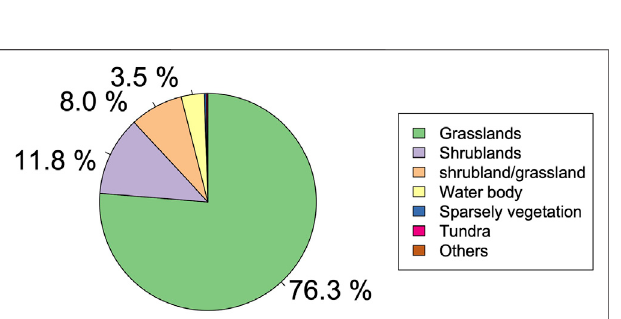
FIGURE8| Percentageofeachsurfacetypetothetotalsurfaceoverthe Yellow River source area in the second nested model domain.